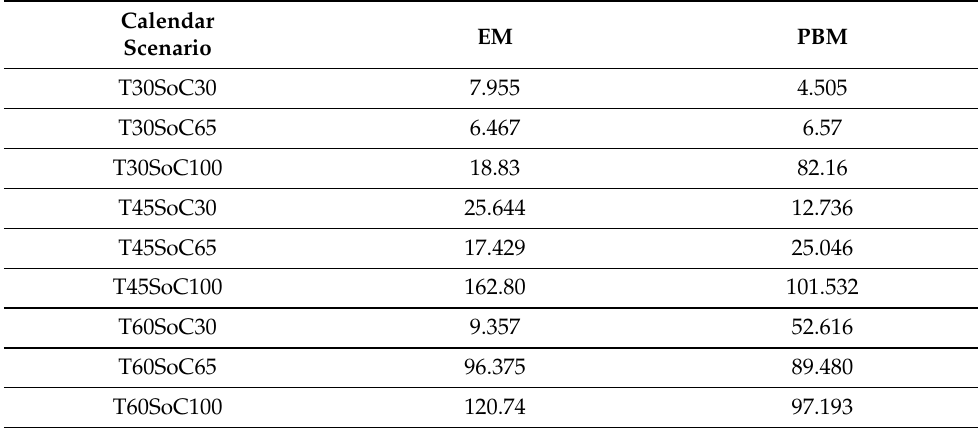
Table 5. Mean absolute error for the resistance increase in calendar aging with all models (expressed in